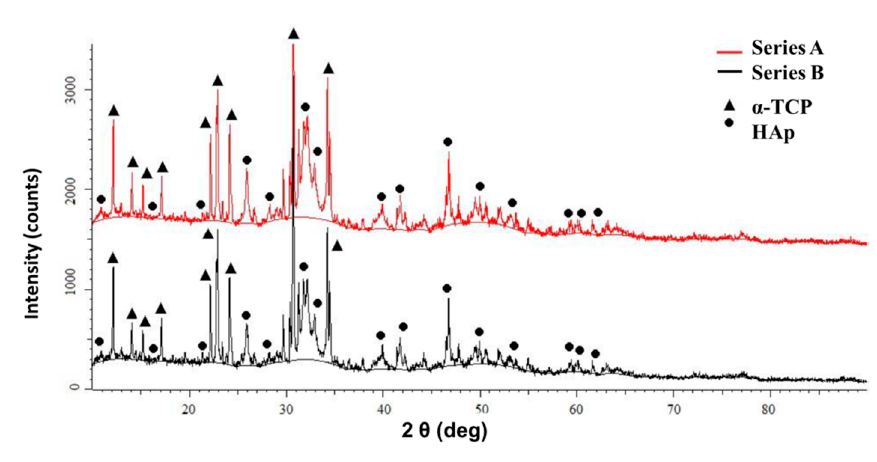
Figure 3. XRD patterns of the biomicroconcretes. Table 2. The phase composition of biomicroconcretes (7 days after setting and hardening). Size of Granules (mm)